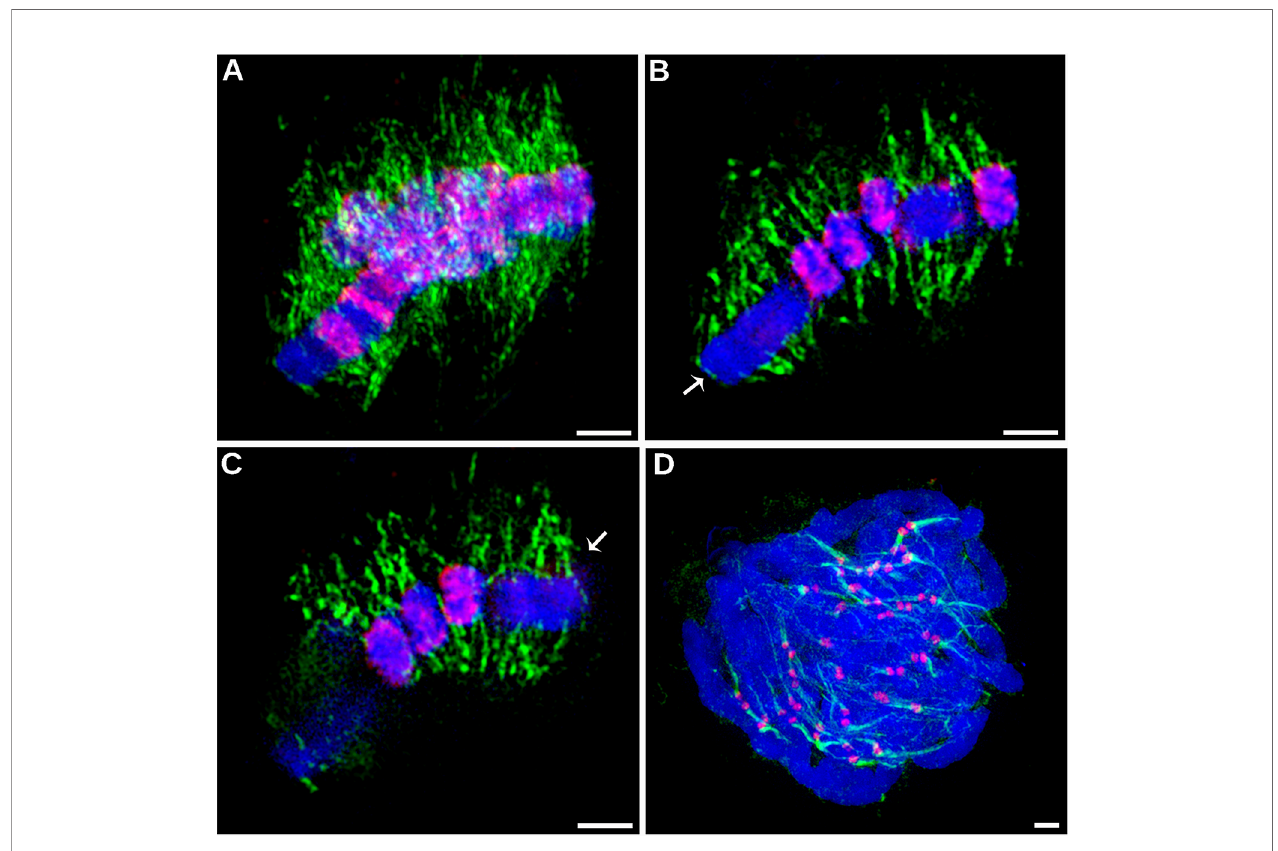
FIGURE 3 | Distribution of CENH3 and spindle attachment sites on chromosomes, investigated by super-resolution structured illumination microscopy (3D-SIM). (A – C) Detection of CENH3 (red) and tubulin (green) on metaphase chromosomes of C. europaea . The CENH3 was detected using mixed antibodies to CENH3 CEURO-1a/b and CENH3 CEURO-2 (red). Microtubules were detected using a -tubulin antibody (green). (A) Maximum-intensity projection image reconstructed from 3D SIM image stack. (B – C) Two optical sections selected from the same 3D SIM image stack. They show that microtubules of the mitotic spindle are evenly attached to chromosomes at their poleward sides and along their entire lengths, regardless of the occurrence of CENH3 signals. Arrows mark chromosome 1 which exhibits large CENH3-free region. The full set of optical sections and corresponding projections are also available as Supplementary Movies 1 and 2 . (D) Detection of CENH3 (red) and a -tubulin (green) on metaphase chromosomes of C. japonica . Note that microtubules attach to the chromosomes exclusively at CENH3- containing domains. Chromosomes were stained with DAPI (blue). Scale bars = 2 µm.